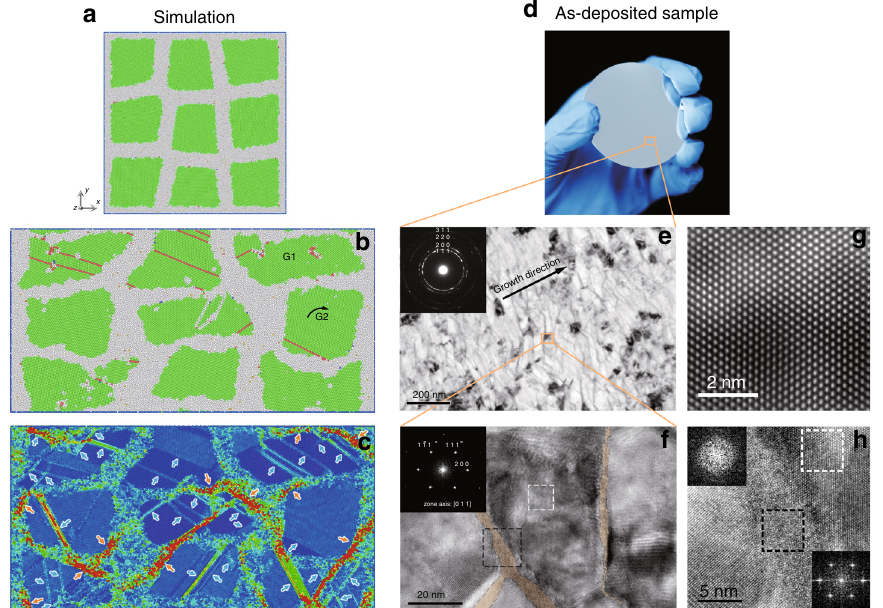
Fig. 1 Hierarchical nanostructure guided from computer simulation. a The atomistic model of the glass-crystal hierarchical nanostructure composed of amorphous Al 85 Ni 15 and Al nanograins. b MD simulated atomic snapshot and c the corresponding atomic shear strain distribution of the hierarchical nanostructured Al alloy at a strain of 30%. ‘ G1 ’ and ‘ G2 ’ in b represent a fl attened ‘ grain 1 ’ and a rotated ‘ grain 2 ’ , respectively. The typical dislocation slips in ‘ G1 ’ contribute to plastic deformation. Large rotation with little dislocation propagation in ‘ G2 ’ may also accommodate the plastic deformation. d Optical image of the hierarchical nanostructured Al alloy. e Cross-sectional TEM image of the hierarchical nanostructured Al alloy, showing Al nanograins surrounded with light – dark contrasted grain – grain interfaces. The selected area electron diffraction (SAED) pattern in the inset denotes the polycrystalline structure. f HRTEM image of the hierarchical nanostructured Al alloy, showing a crystalline Al nanograin is surrounded by amorphous phase (post-colored by light yellow). The inset is fast Fourier transformation (FFT) image of the white dashed rectangle region in the main image, showing the fcc structure with zone axis of [0 1 1]. g , h are the zoomed-in images of white and black dashed rectangle regions in ( f ), respectively. g Shows a defect-free fcc structure. h Shows a nano-sized amorphous phase forms between the two grains. The FFT image (lower right inset of h ) of the crystalline region (white dashed rectangle) reveals pronounced spots pattern. By contrast, the FFT image (upper left inset of h ) of the black dashed rectangle region in h shows a diffuse pattern, indicating the amorphous structure. The termination ripples feature may be due to the small sampling size